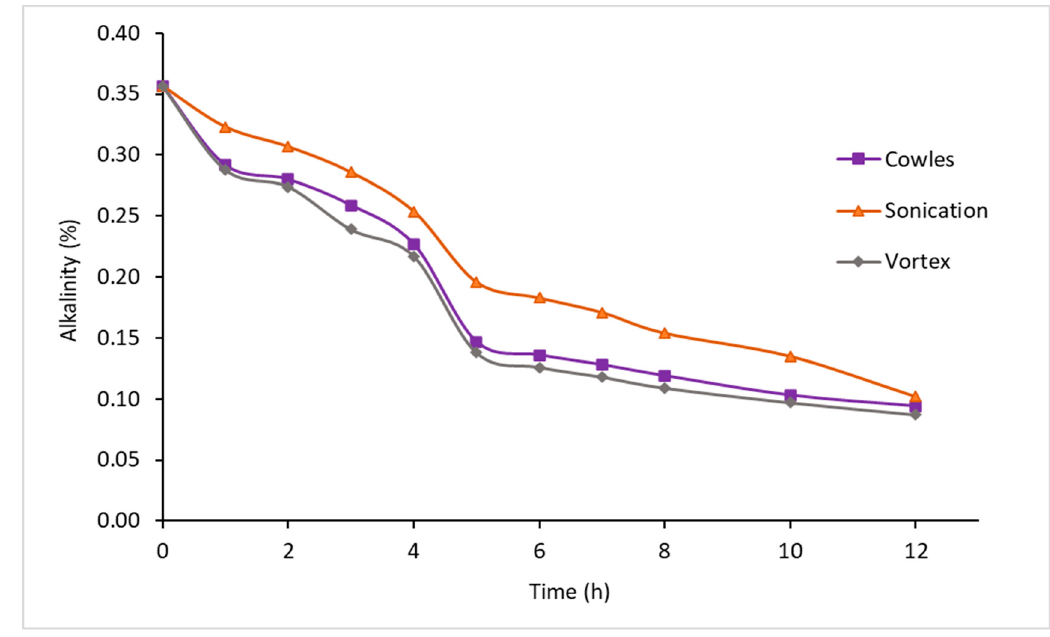
Figure 5. NRLF deammonification.